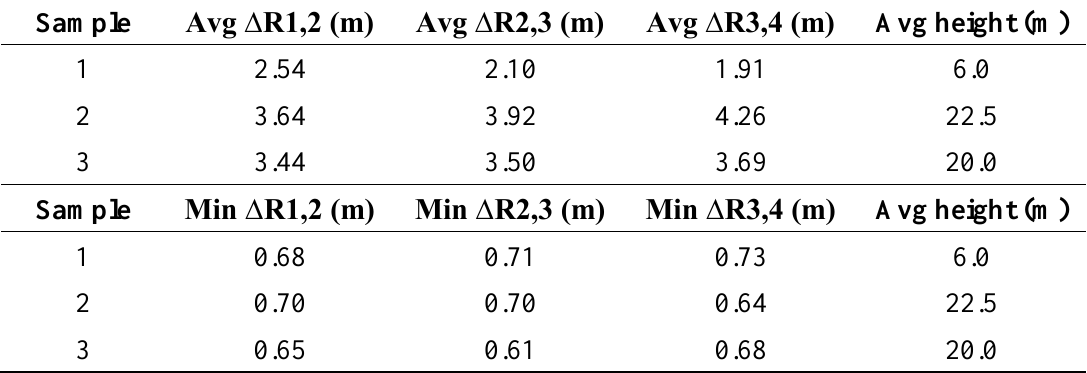
Table 2. ALTM-Orion: Average and minimum multiple return separation distances for the forest data; the last column shows the average vegetation height in the selected samples.